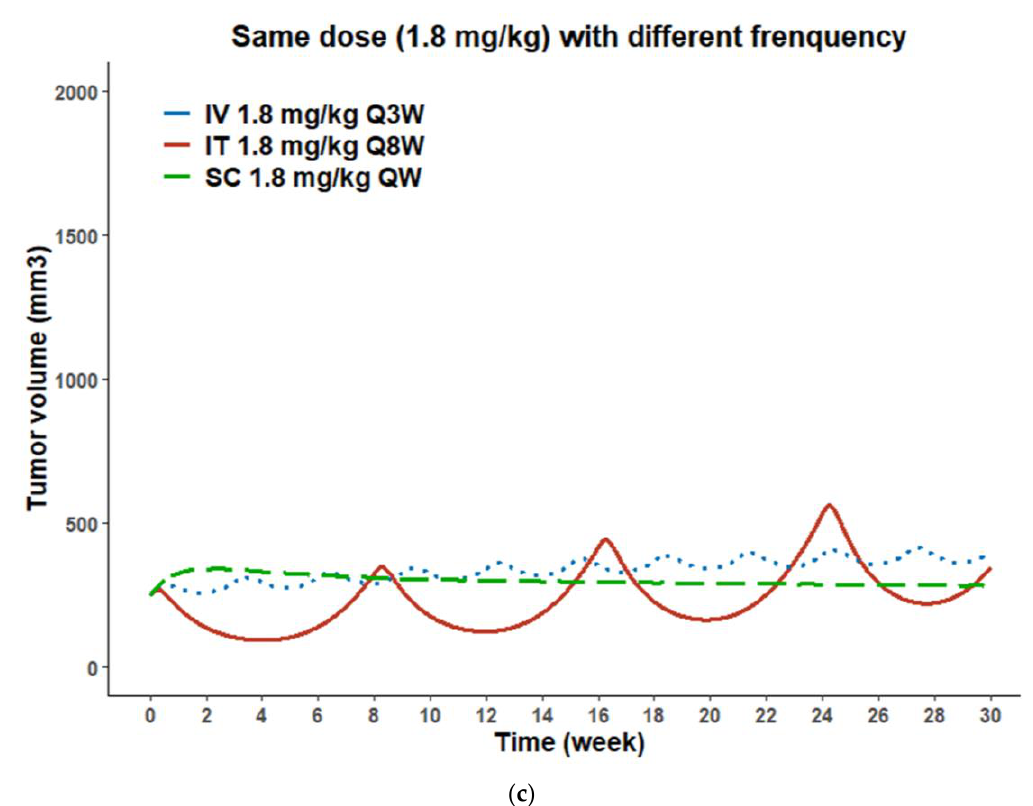
Figure 9. PK/PD model simulated tumor growth inhibition (TGI) after treatment with T-vc-MMAE administered via intravenous (IV), intratumoral (IT), or subcutaneous (SC) routes. ( a ) Simulation for clinically approved dosing regimens of 1.8 mg/kg given Q3W for 6 cycles; ( b ) simulation of dosing amounts required to achieve similar TGI after IV, IT, and SC administration with the same dosing frequency (Q3W); ( c ) simulation of dosing frequency to achieve similar TGI after IV, IT, and SC administration with the same dosing amount (1.8 mg/kg).